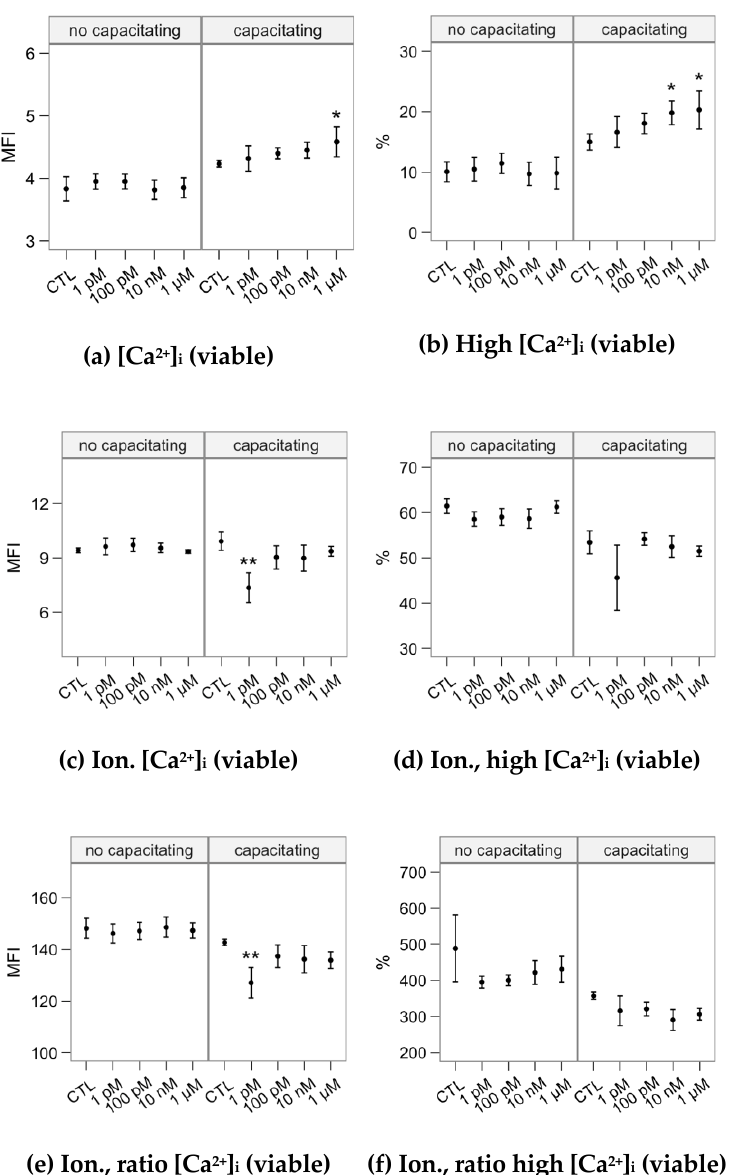
Figure 7. Effects of incubating bull spermatozoa with different melatonin concentrations on intracellular calcium concentration (Control, no melatonin, as reference). Plots show mean ± SEM for each concentration in the two in the absence (no capacitating) or presence (capacitating) of heparin. (variable names expanded in Figure 2). Asterisks label melatonin effects significantly different from the Control (** p < 0.01).